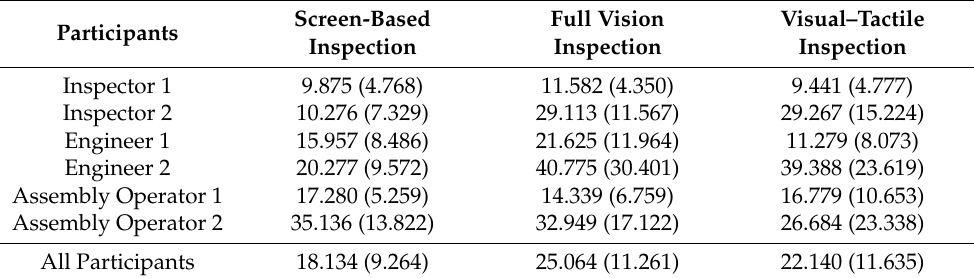
Table 4. Decision time of each participant by inspection method (in